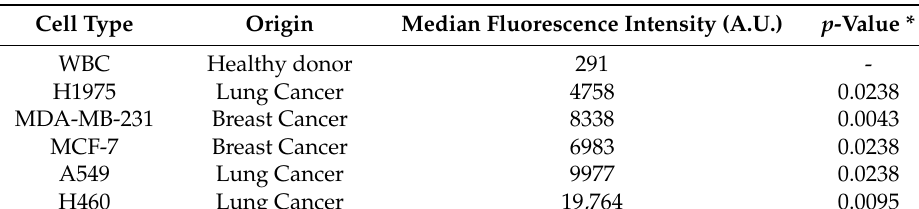
Table 1. Uptake of glucose analogue by different cell types. The 2-NBDG uptake is expressed as mean fluorescence intensity and standard deviation (SD). Each cell line and WBC from three different healthy subjects were tested in triplicate. * p value obtained comparing cell lines and WBC by Mann–Whitney test.